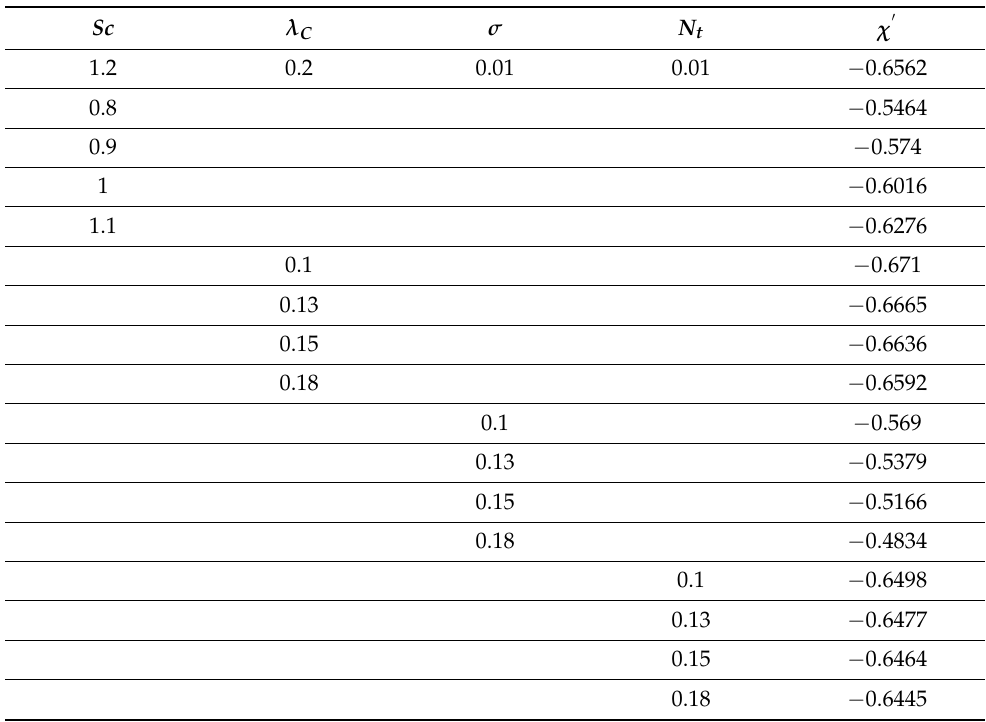
Table 5. The numerical values of χ (cid:48) with respect to pertinent varied